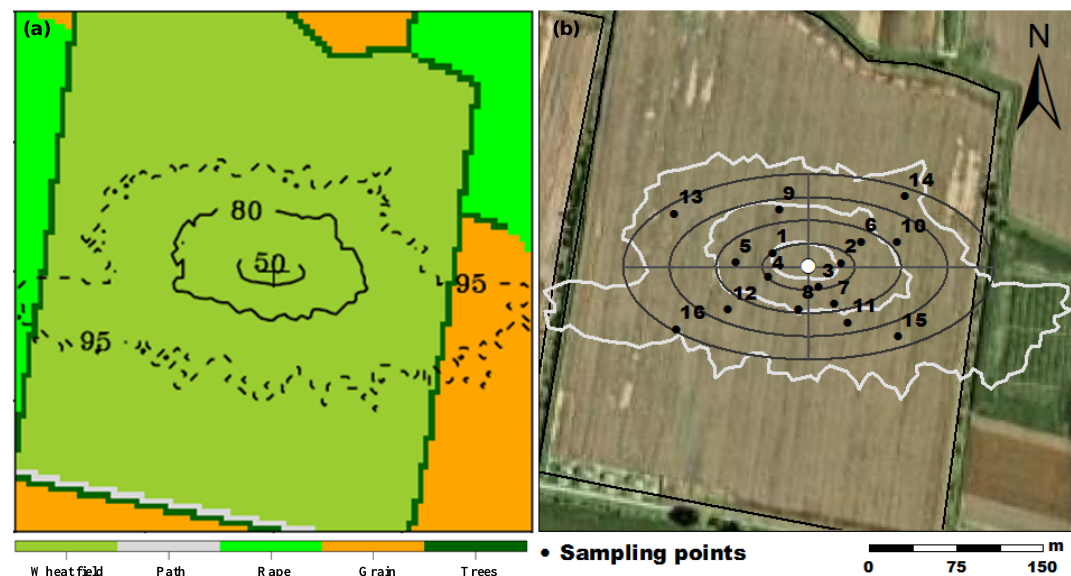
Figure 2. (a) Footprint of the eddy covariance station EC 3 in 2012. Black isolines indicate the fraction of the source area of 50, 80 and 95% of measured EC fluxes. (b) Positions of sampling points within the footprint of EC3 used to measure soil water storage.